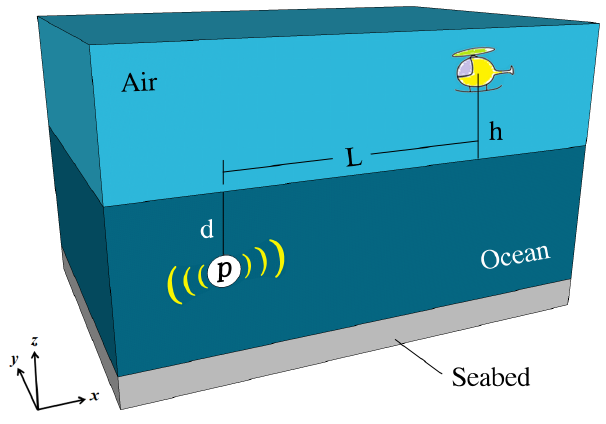
Figure 1. Schematic diagram of underwater pressure wave aeromagnetic